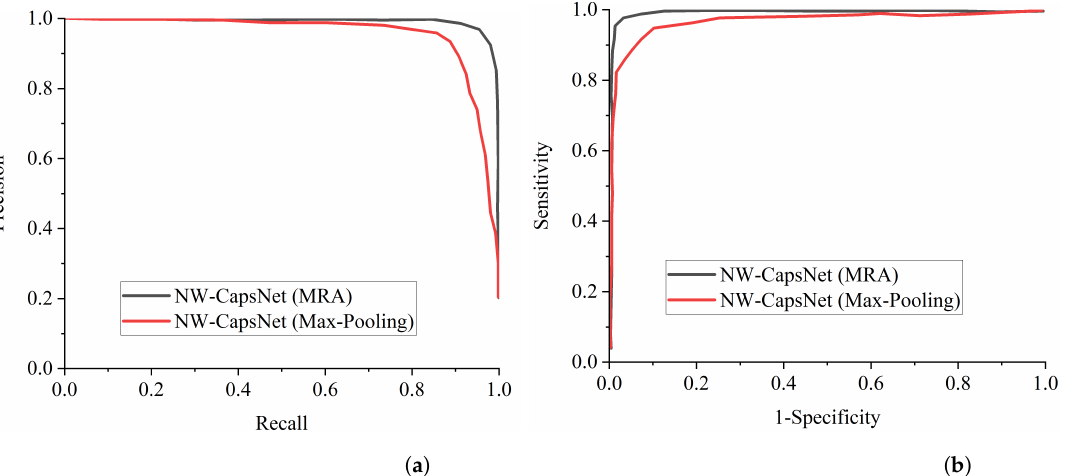
Figure 6. Effect of down-sampling operation on the performance of the proposed model. ( a ) Precision– recall curves of our two stage experiments showing the influence of down-sampling operation on the model performance. ( b ) ROC curve of our two stage experiments showing the influence of down-sampling operation on the model performance.